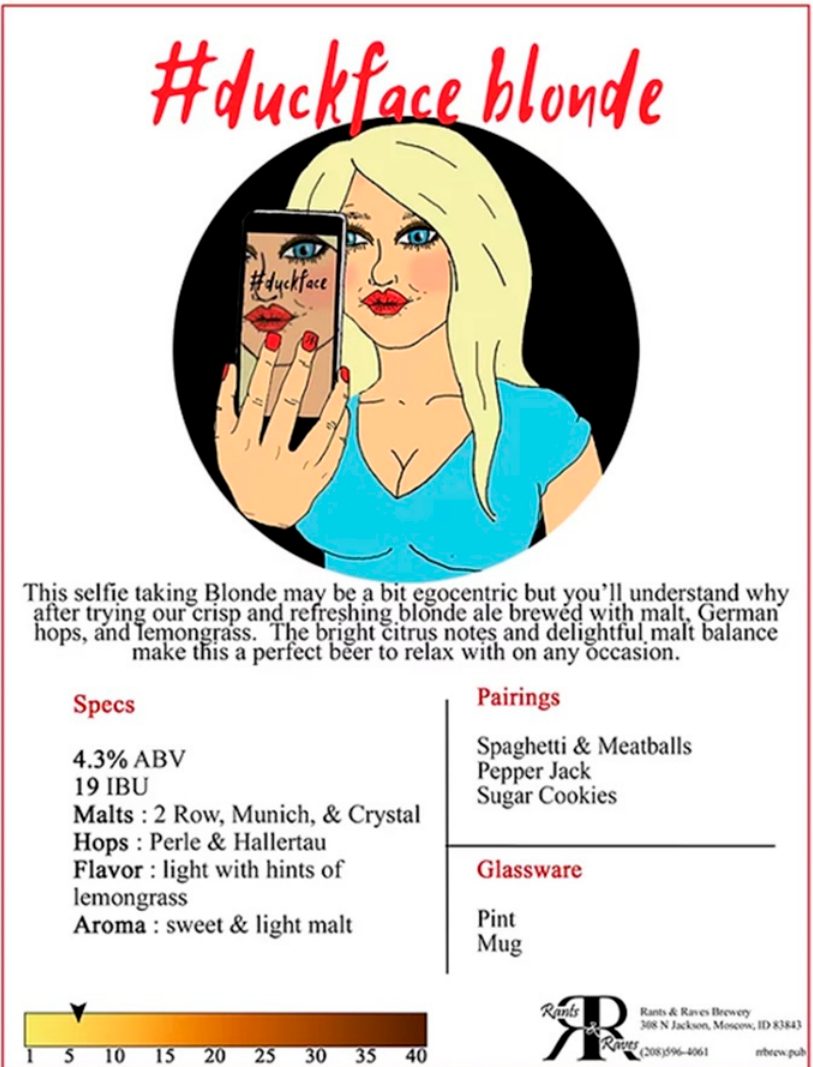
Figure 7. A particularly striking example of how a low ABV offering is represented by a craft brewery. (Screenshot by the authors from https://www.rantsravesbrewery.com; accessed on 30 July 2022).